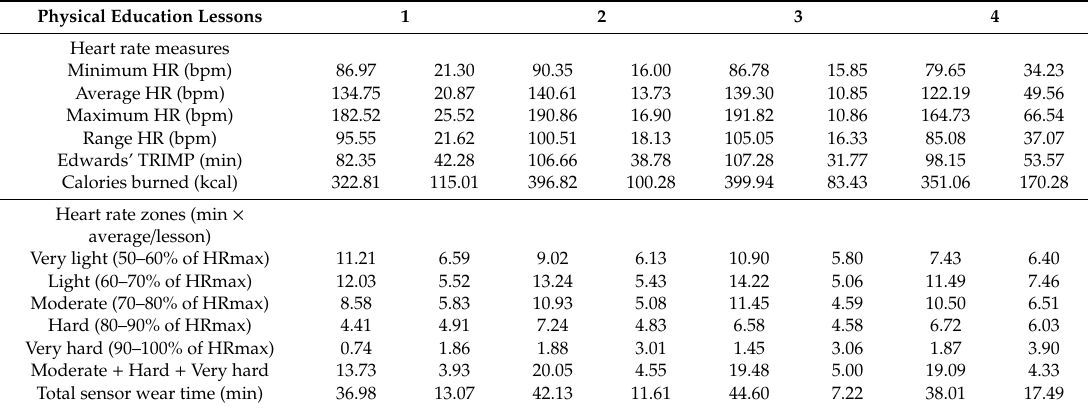
Table 2. Descriptive characteristics of heart rate measures for each physical education lesson ( n = 130).